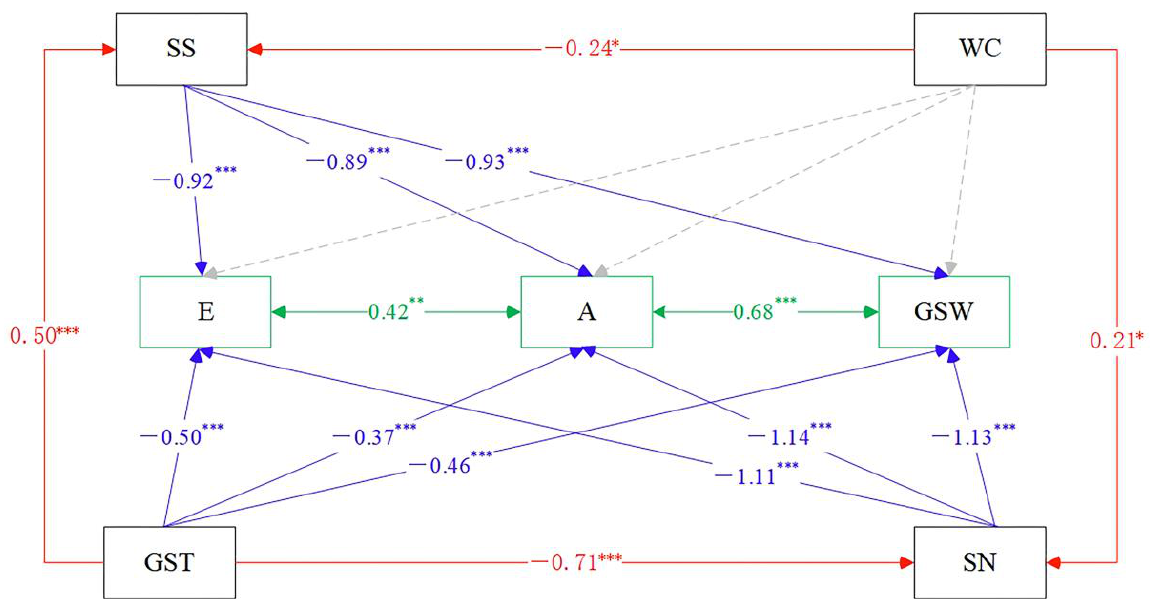
Figure 5. Effects of environmental factors on leaf functional traits: GFI (goodness of fit index: 0.970) > 0.600: indicates that the model has a good fit. Notes are the same as in Tables 1 and 2 and Figure 3. The green lines represent the effects among plant leaf functional traits, the red lines represent the effects among environmental factors, the blue lines represent the effects of environmental factors on plant leaf functional traits, and the dotted lines represent no significant effect. The differences significant at the 0.001, 0.01, and 0.05 levels are indicated with ***, **, and *, respectively.